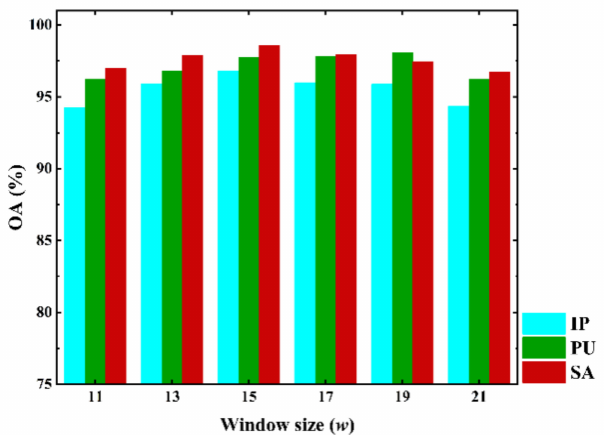
Figure 9. Comparison of OA using different w values for the three